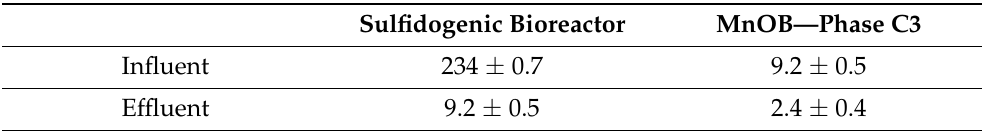
Table 2. Concentrations of dissolved organic carbon (DOC; mg L − 1 ) in influent and effluent liquors from the sulfidogenic bioreactor and the effluent liquors from the MnOB as mean values and standard deviations (n = 5).